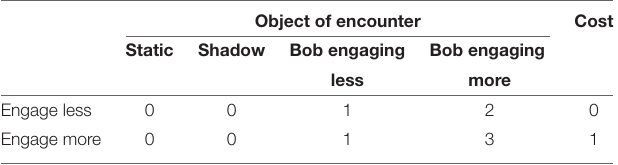
TABLE 2 | Choices faced by Alice, with corresponding payoffs and costs, were all the information